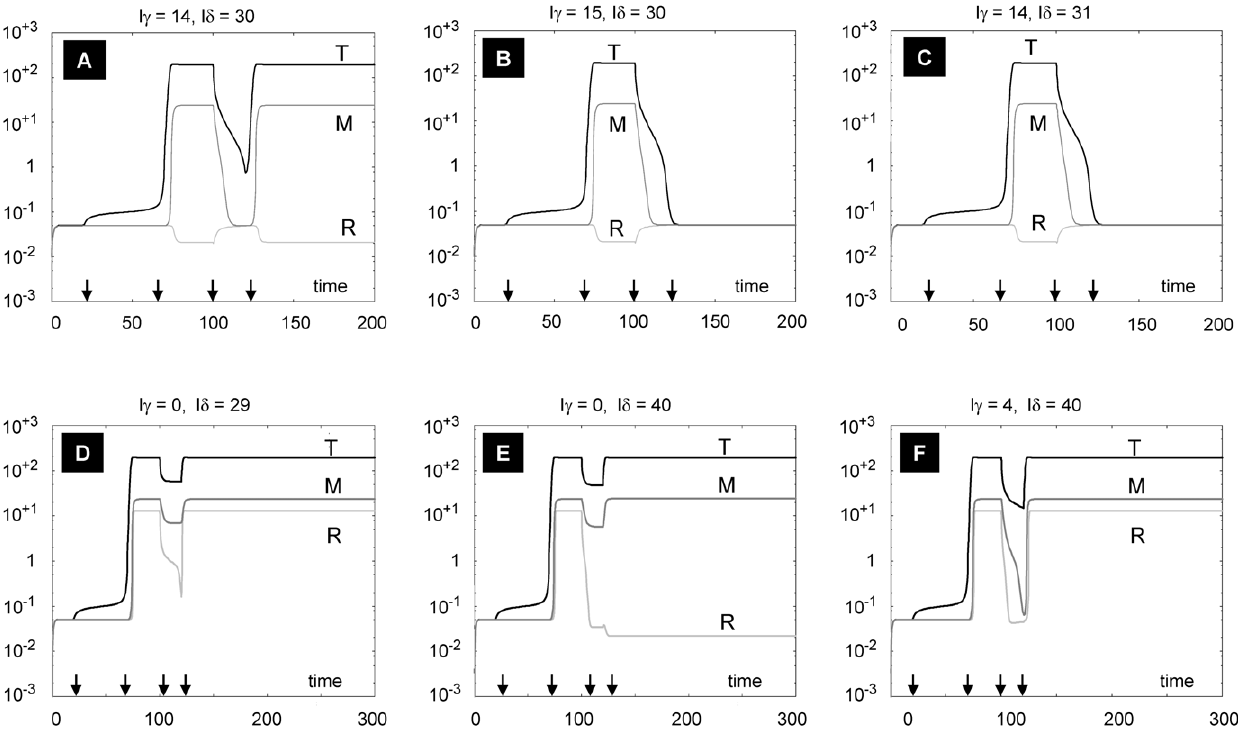
Figure 6. Combination therapies using anti-IL2 and anti-IFN c . The system is first allowed to reach low steady states of all variables, and then exposed to a square pulse of antigen (with amplitude A=100) from t=20 to t=70 to obtain a sarcoid state. For (A)-(C), k 2a =2.0. Combinations of anti-IFN c (I c ) and anti-IL2 (I d ) are applied as square pulses at the same time, between t=100 and t=120. The combination in (A) is not successful, while those of (B) and (C) are successful in pushing down the levels of T and M (although there is a slight increase in R compared to its level in (A), R is still very low). For (D)–(F), k 2a =2.1. An increase in anti-IL2 (I d ) from 29 to 40 brings down R, but not T and M. Note that a small addition of I c as shown in (F) returns R to the high steady state level. All parameters as in Table 2, except k 2a .